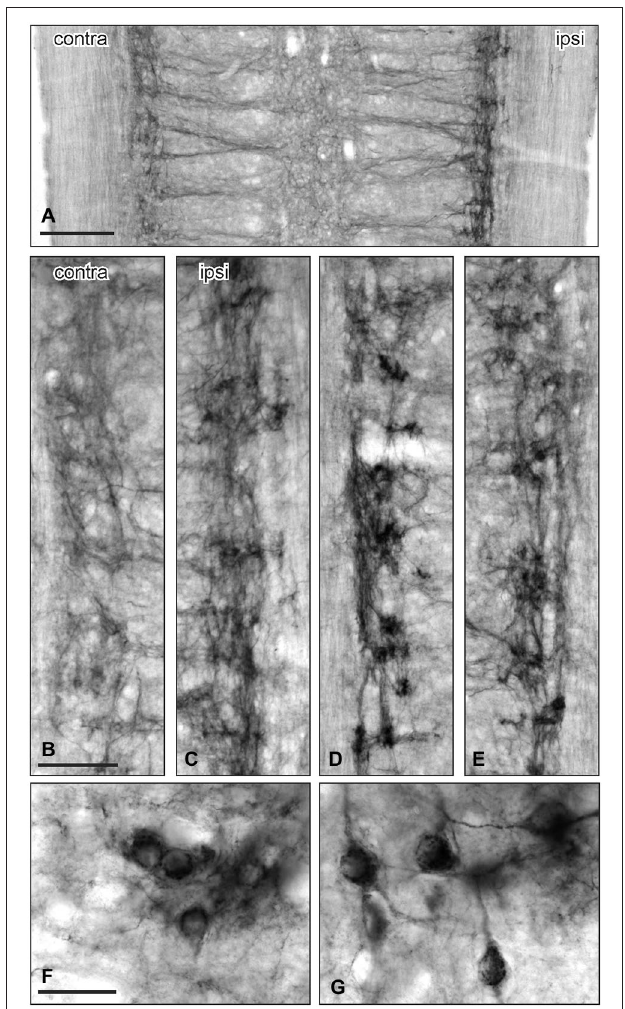
FIGURE 3 | GFR α 1-IR in the sacral parasympathetic nucleus (SPN) viewed in horizontal spinal cord sections after pelvic nerve injury . (A–C) : Asymmetric upregulation of GFR α 1-IR in the SPN ipsilateral to a unilateral pelvic nerve transection. (D,E) Symmetric upregulation of GFR α 1-IR in the SPN on both sides after bilateral pelvic nerve injury. (F,G) Examples of GFR α 1-IR somata in SPN ipsilateral to pelvic nerve transection. Scale bars represent 200 µ m (A) , 50 µ m (B–E) , and 50 µ m (F,G)